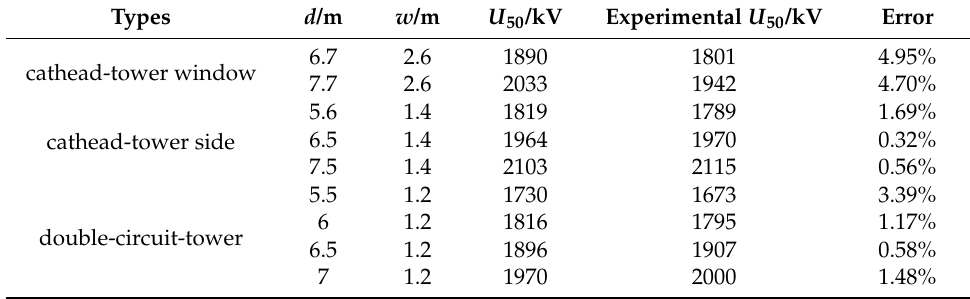
Table 2. Calculation of different gaps breakdown